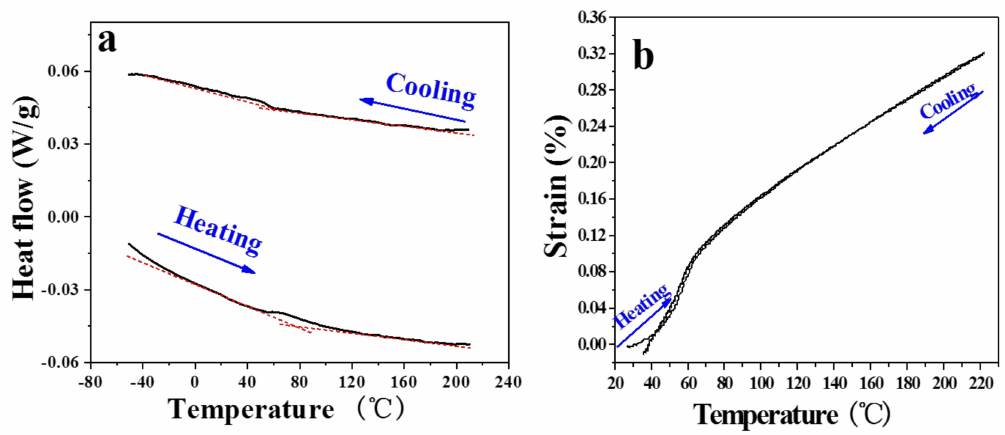
Figure 1. Phase transformation characterization of intermetallic Ti 3 Sn. ( a ) DSC result. ( b ) Thermal expansion test